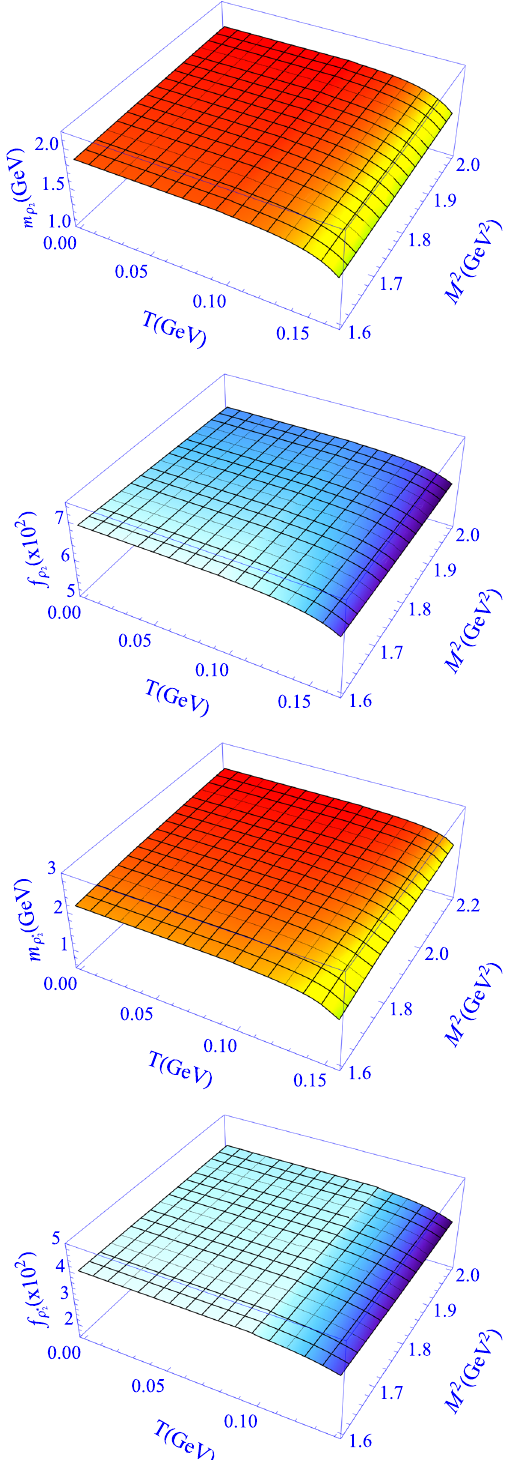
Fig. 2 The effect of temperature on mass (first) and decay con- stant(second)for ρ 2 mesonandmass(third)anddecayconstant(fourth) for ρ ∗ meson with respect to PDG data, 2